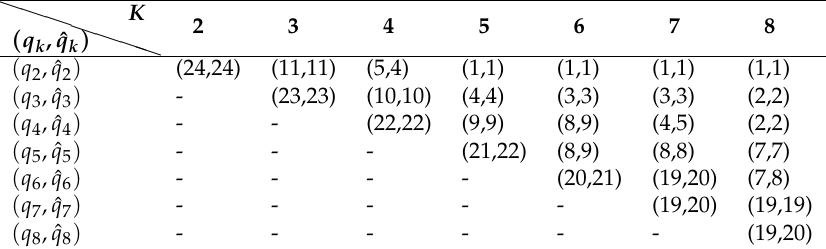
Table 3 lists values of optimal thresholds q k and corresponding heuristic solutions ˆ q k . As we see it, the maximum deviation of the optimal thresholds from the heuristic solution is 1 independently of the number of servers. Table 3. Threshold values q k and ˆ q k , k = 2, . . . , K